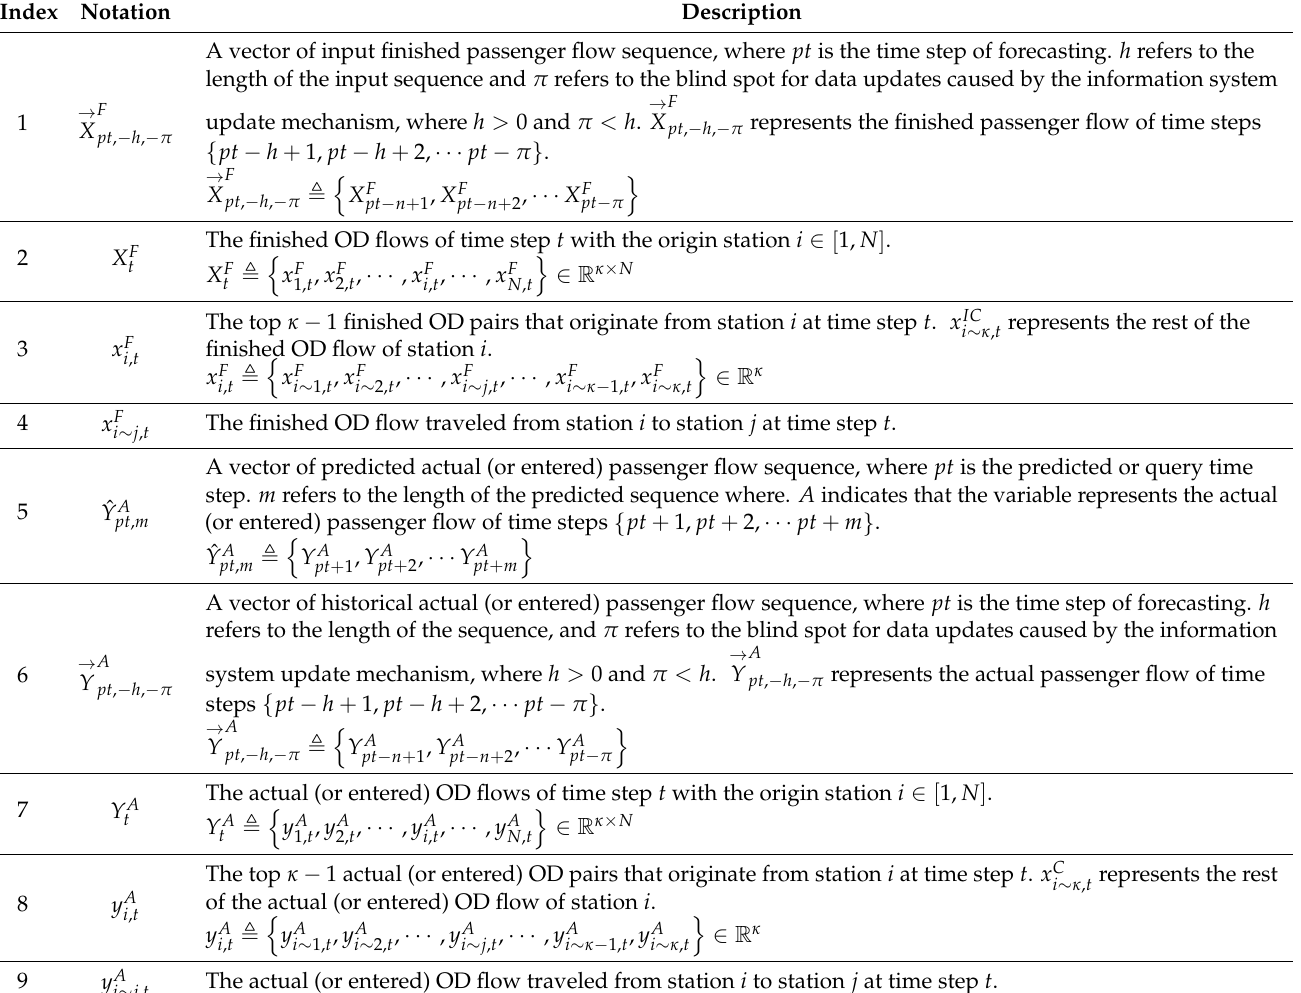
Table 1. Key notations in forecasting task.